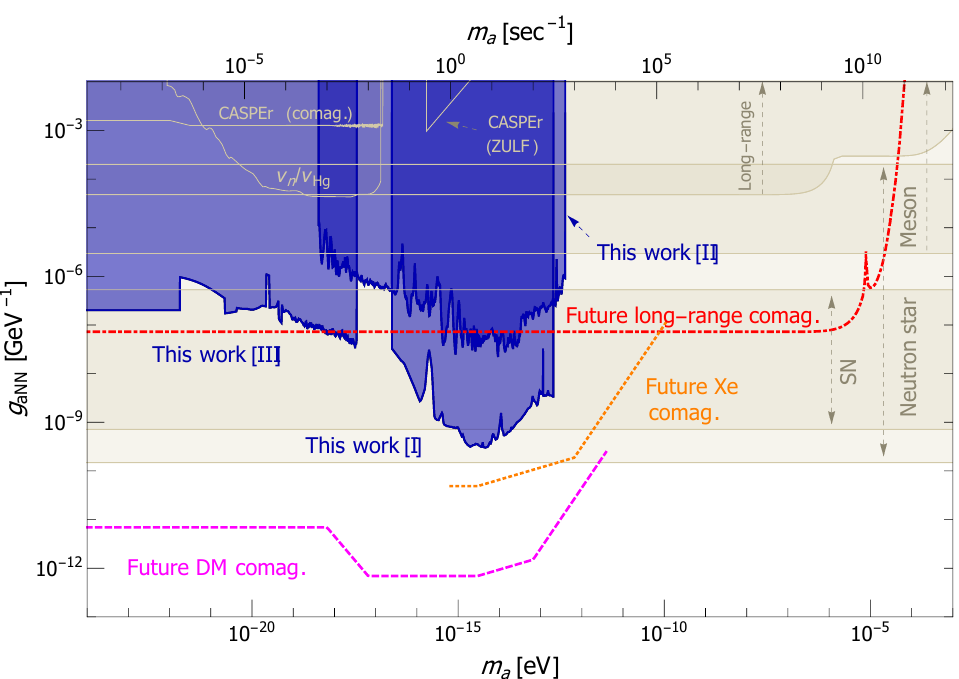
Figure 3 . Constraints and projected reach for ALP-neutron couplings. The shaded blue regions represents the 95% C.L. bounds derived in this paper from datasets I [47], II [48] and III [49]; the bound derived from dataset III continues to arbitrarily small ALP masses. The sudden increase of the bound at ultra-light masses is due to longer measurement-time being available at those masses, and not an increased sensitivity at low frequencies. The shaded ‘long-range’ region comes from the non-observation of deviations from the gravitational 1 =r 2 at short distances [43], together with the bound from long-range spin-dependent interactions [47]. The ‘ (cid:23) n =(cid:23) Hg ’ shaded region comes from ref. [44], which compared the e(cid:11)ect of anomalous DM axion (cid:12)elds on Hg and neutrons. Similarly, the ‘CASPEr (comag.)’ region is excluded by the non-observation of the e(cid:11)ect of anomalous DM axion (cid:12)elds on 1 H and 13 C [46]. The ‘CASPEr (ZULF)’ shaded region indicates the phase-I bound of that experiment [45] which looks for anomalous (cid:12)elds by utilizing NMR methods. The last three